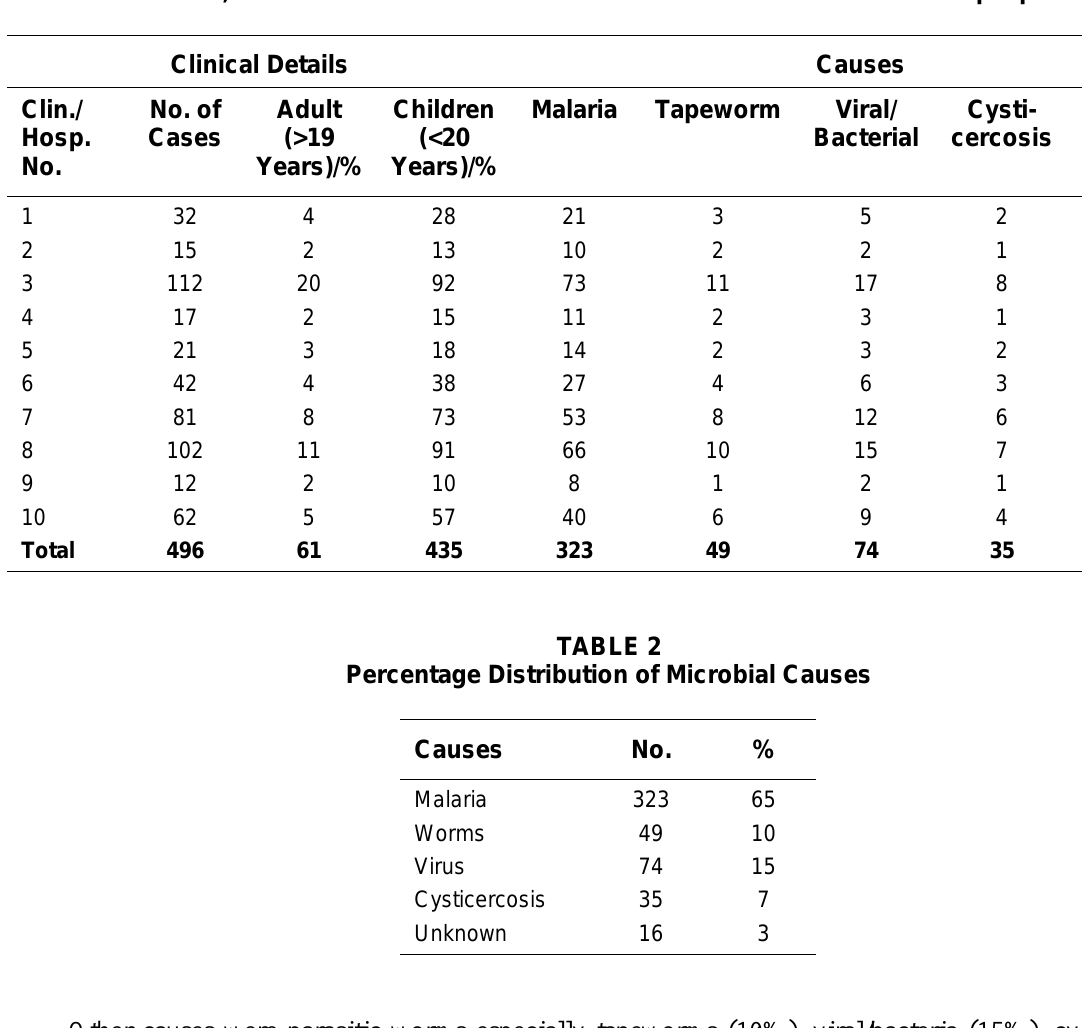
Clinical Details, Adult and Child Distribution of Different Microbial Causes of Epileptic Seizures